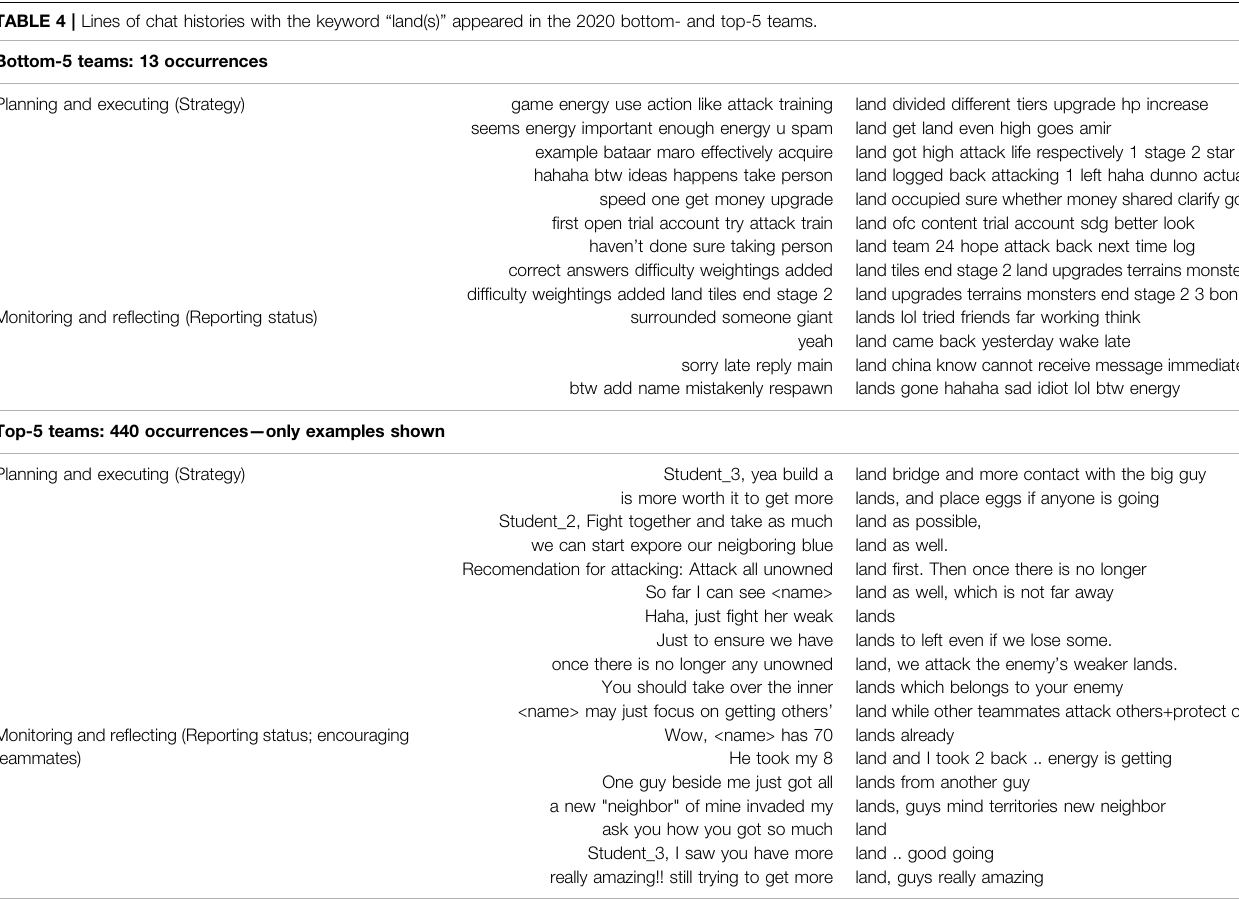
Note: Function words which are irrelevant to the analysis were removed from the lines the Problem Solving keywords collected from the 2020 top-5 teams compared to only 6.1% of those collected from the bottom-5 teams. There were 13 occurrences of “ land(s) ” in the bottom-5 teams, with